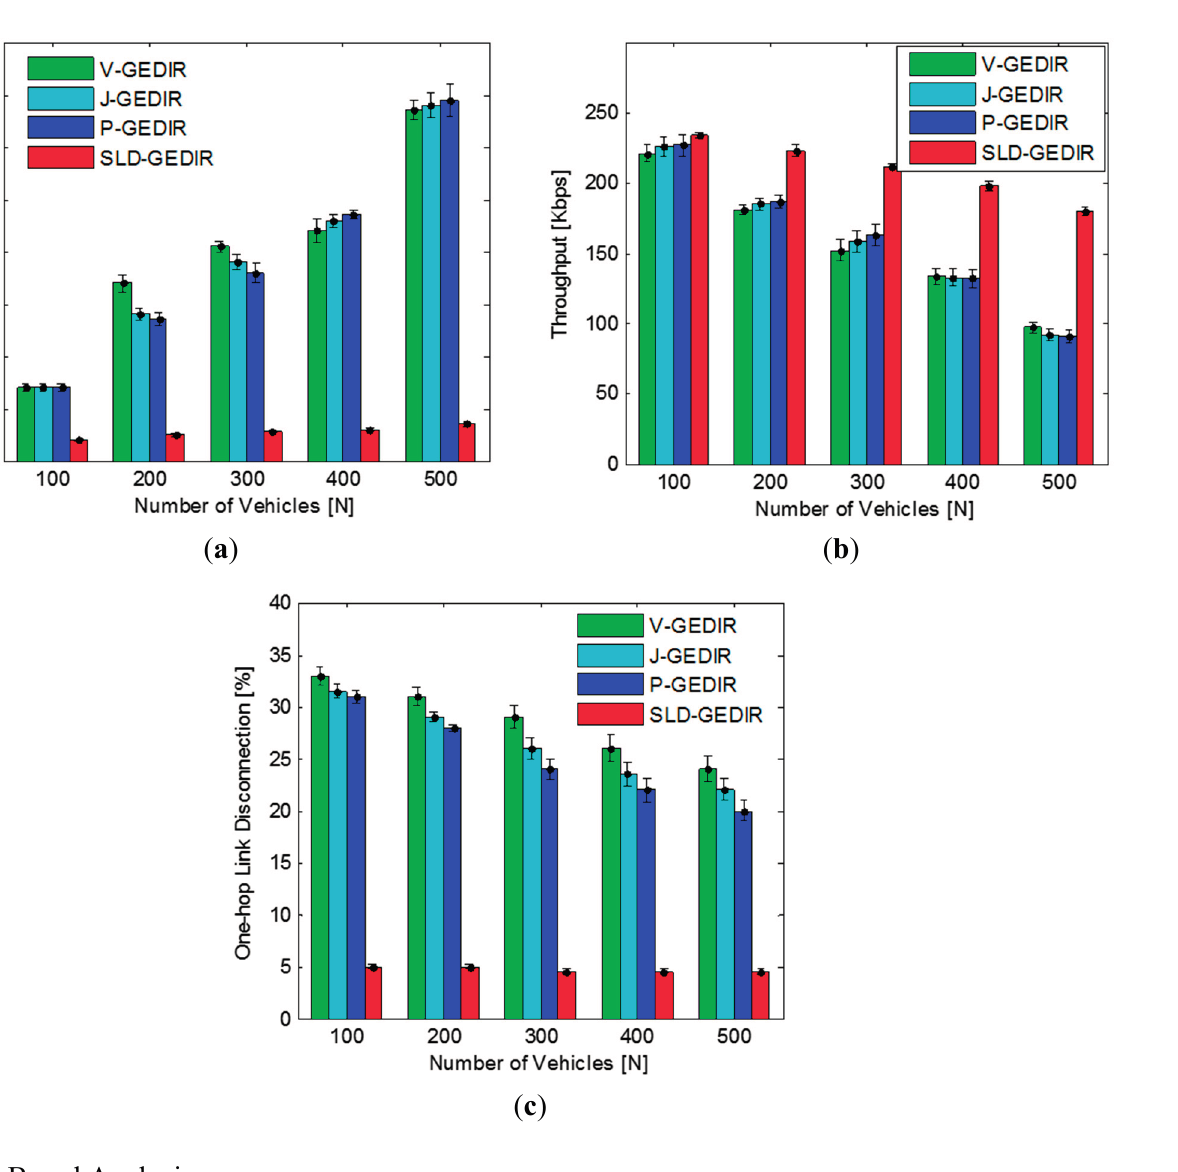
Figure 11. Impact of density in ( a ) end-to-end delay; ( b ) throughput and ( c ) one-hop link